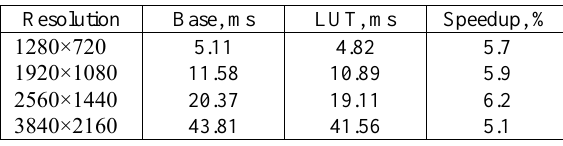
Table 3. Comparison of 1-level DWT calculation in basic method (Base) and proposed lookup table (LUT).